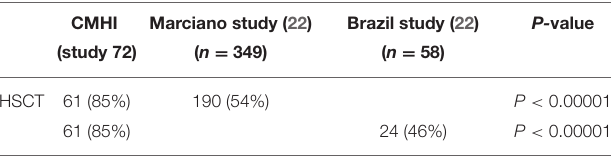
TABLE 4 | Composition of the frequency of HSCT procedure implementation in patietns with SCID.